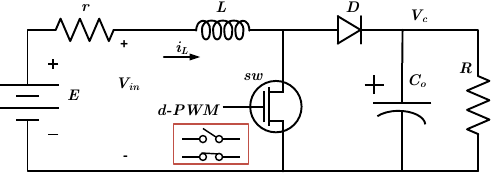
Figure 1. Generalized power model for DC-DC boost